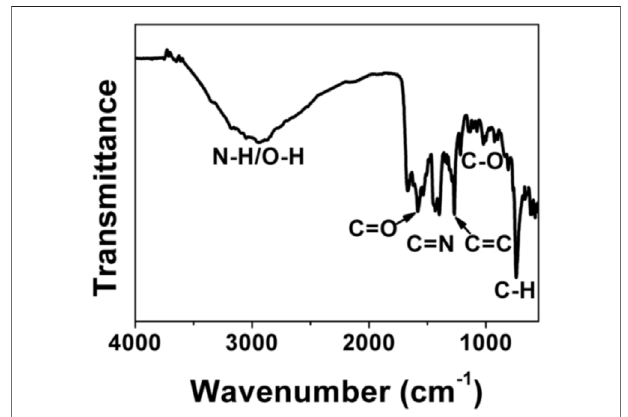
FIGURE 4 | (A) XPS spectrum of BAPTCDs and (B – D) the high-resolution XPS spectra of C 1s, N 1s, and O 1s, respectively.